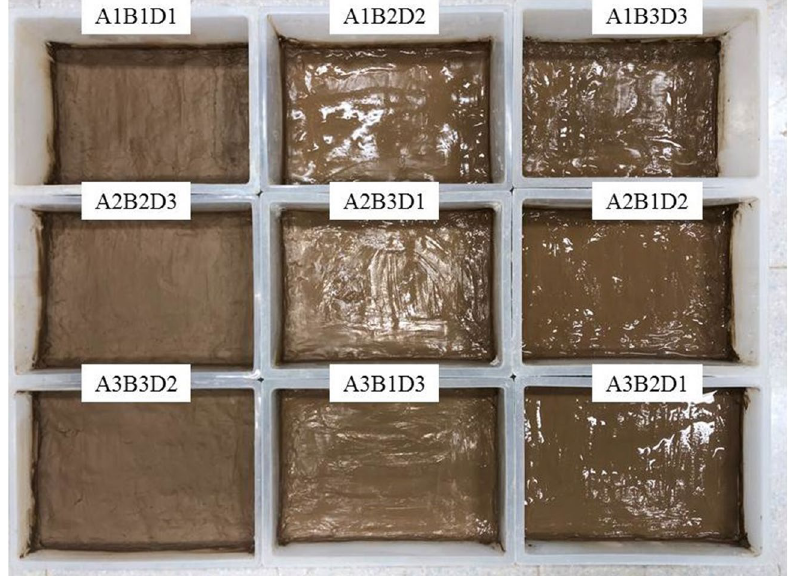
Figure 4. Samples and moulds.